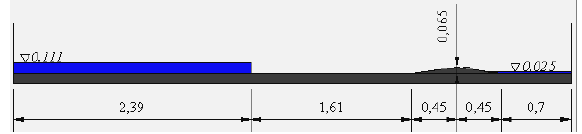
Fig. 9. Experimental set-up and initial conditions, all dimensions in